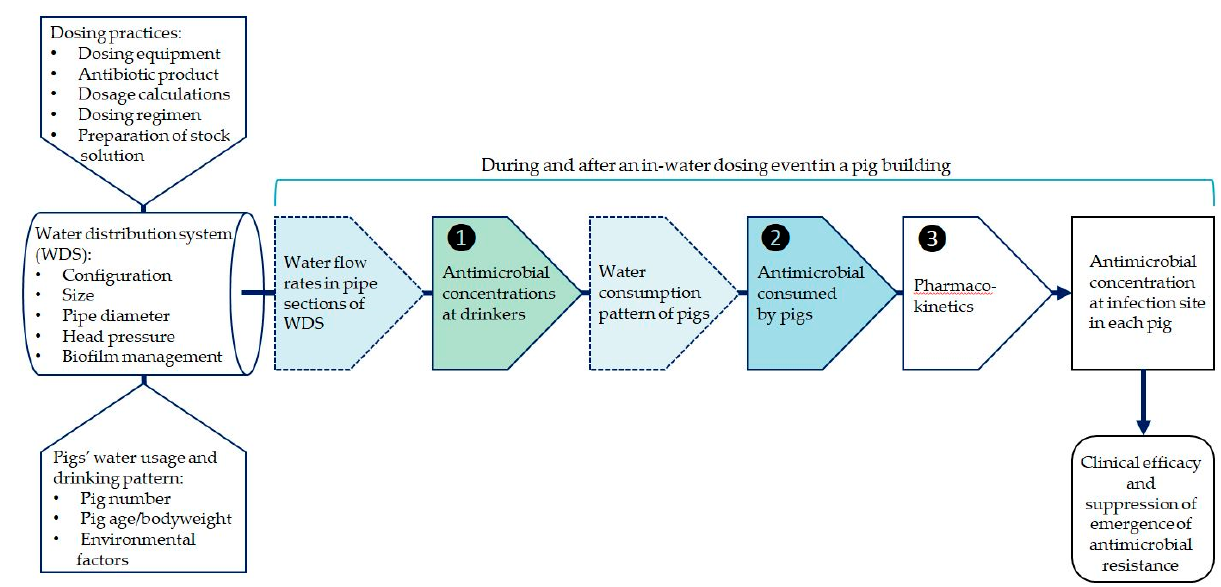
Figure 1. The process of in-water dosing in a pig building, showing three sources of between-animal variability in systemic exposure to an antimicrobial (numbered 1, 2 and 3).